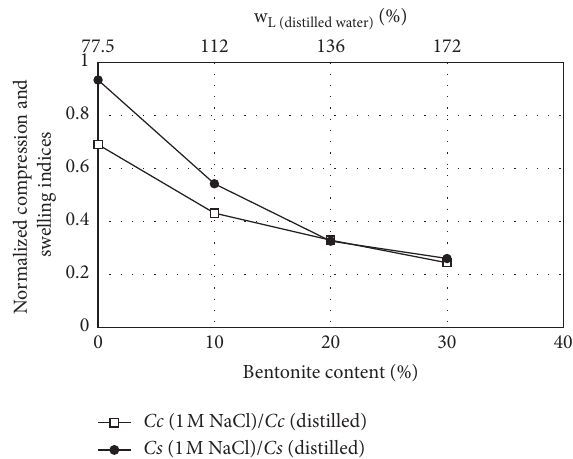
Figure 4: The relationship between the normalized compression and swelling indices concerning the pore fluid and bentonite